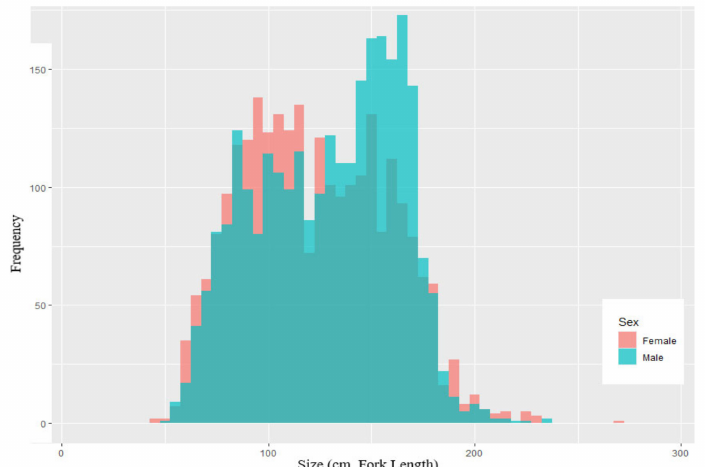
Figure 2. Size frequency distribution of silky shark (5205) from 2010 to 2020 (aggregated). The pink color indicates female sharks (2527), light blue color indicates male specimens (2678), and the medium shade blue is an overlap between female and male silky sharks.